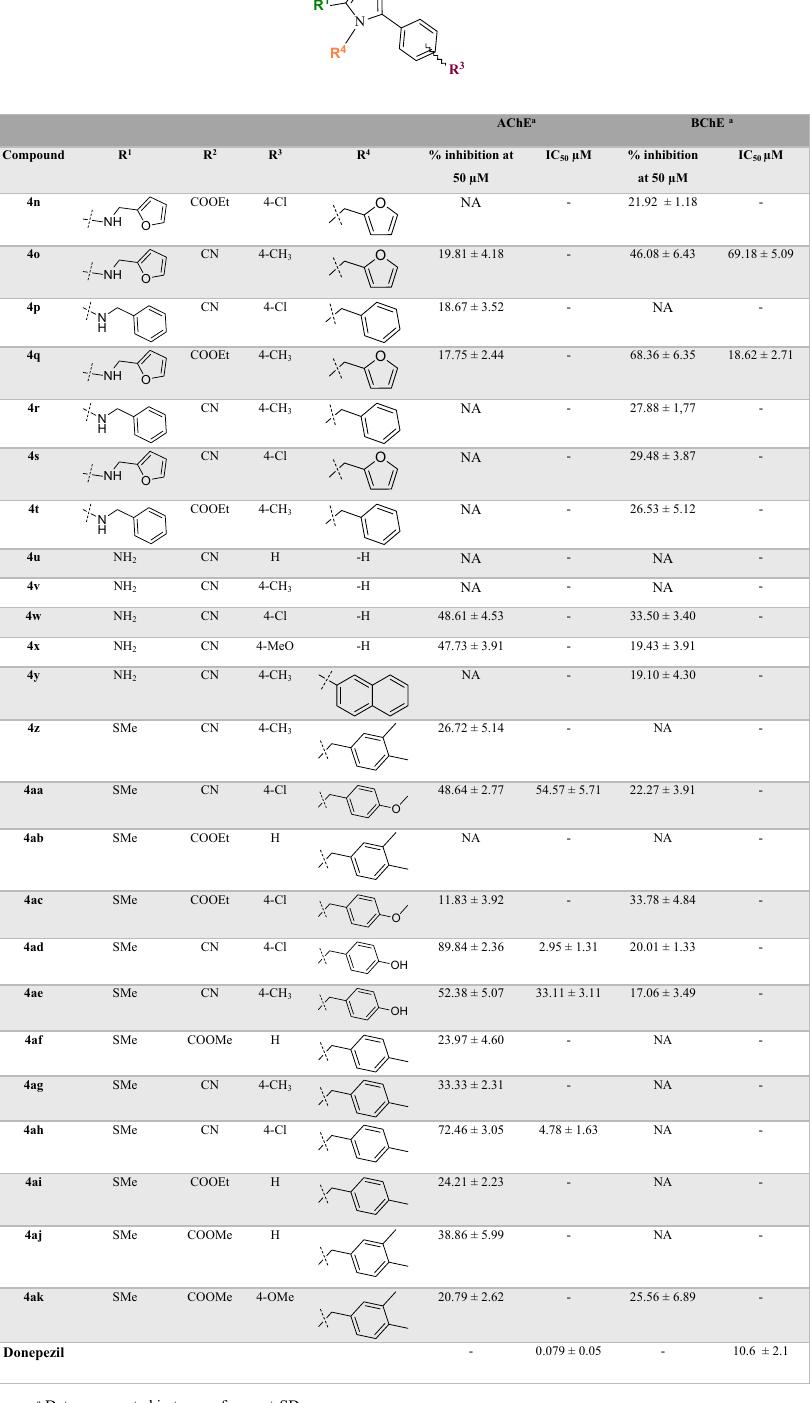
Table 3. IC 50 values and percent inhibitory activity of polysubstituted pyrroles against AChE and BChE enzymes a